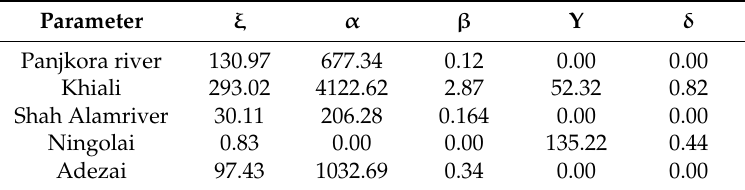
Table 5. Parameters values of Wakeby distribution for five stations in